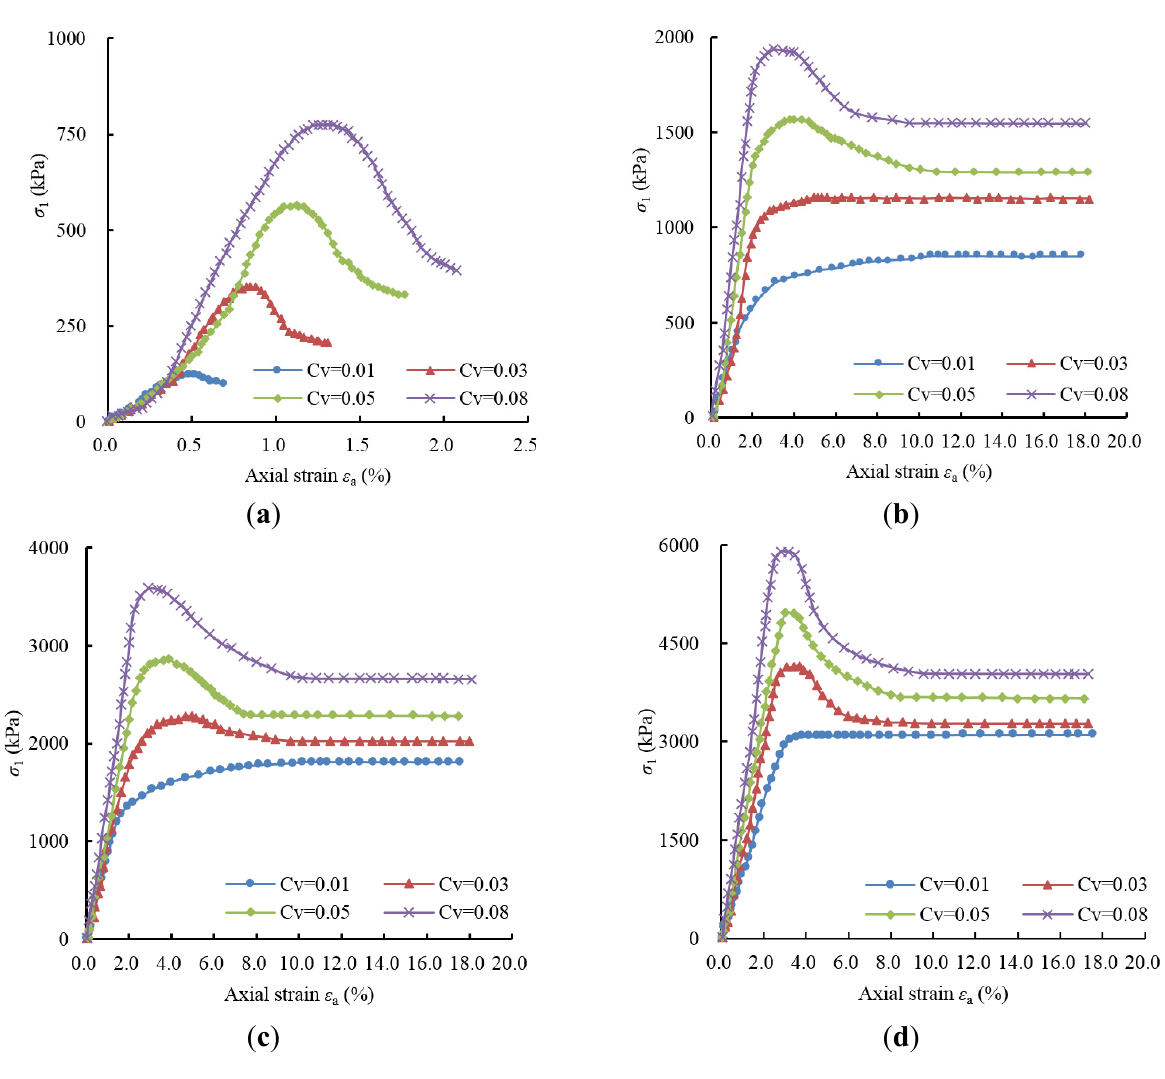
Figure 7. Stress-strain relationships of OPC cement sand samples under different conditions: ( a ) 0.00 MPa; ( b ) 0.25 MPa; ( c ) 0.50 MPa; ( d ) 1.00